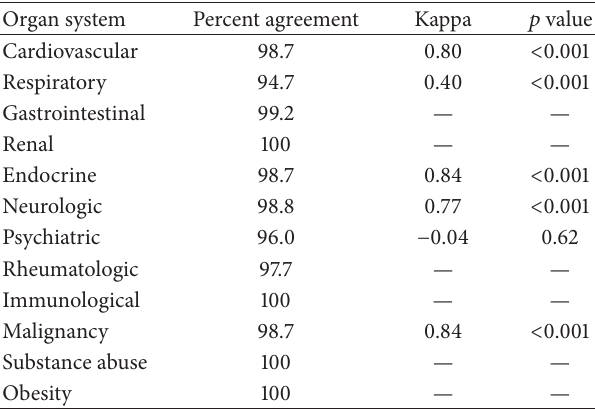
Table 3: Percent agreement and kappa between medical interview (MI)and PRACE-27assessmentsfordata grouped bydiseasesystem and overall comorbidity